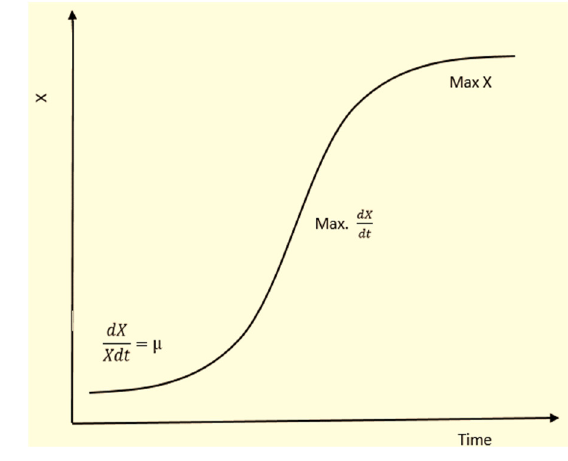
FIG. 1: TYPICAL GROWTH CHARACTERISTICS OF MICROALGAE [30] As seen from the Fig.1, when the algal cell concentration is low and mutual-shading is assumed to be negligible, growth rate increases exponentially and specific growth rate